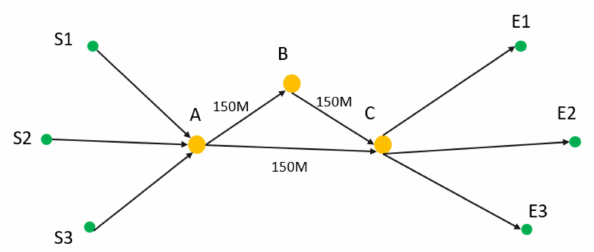
Figure 8. Network topology.